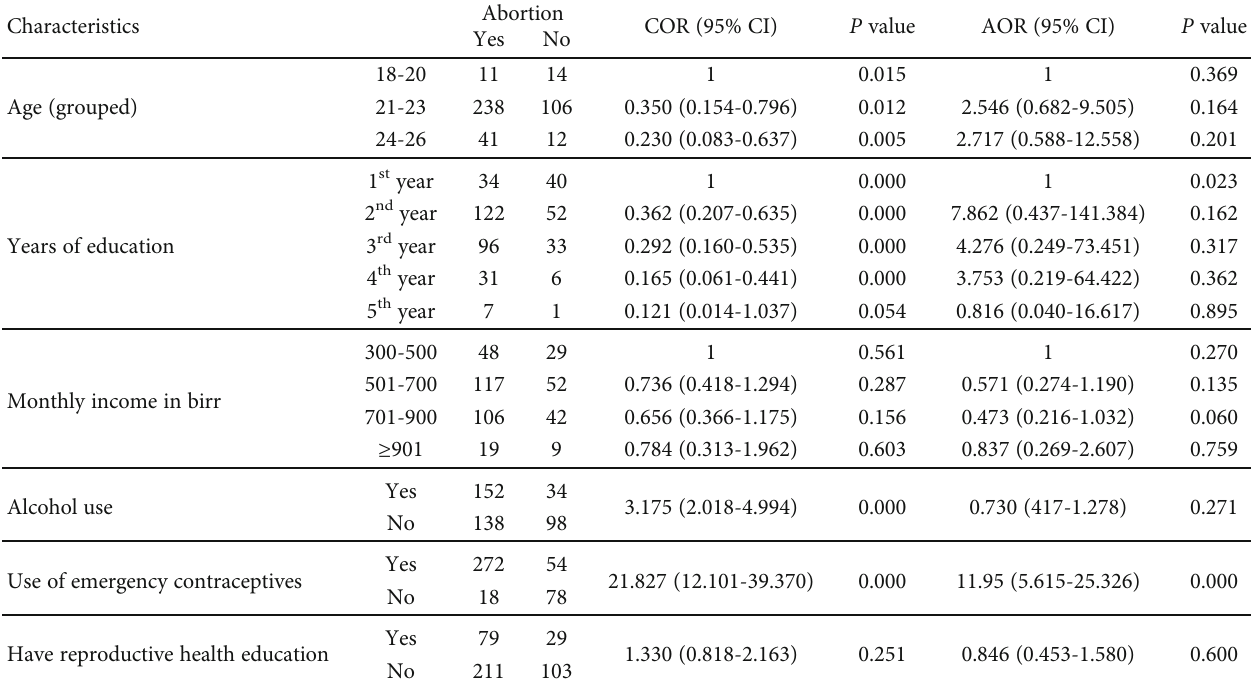
Table 4: Factors associated with induced abortion among Hawassa University students, SNNPR, Ethiopia, April 2019. Characteristics